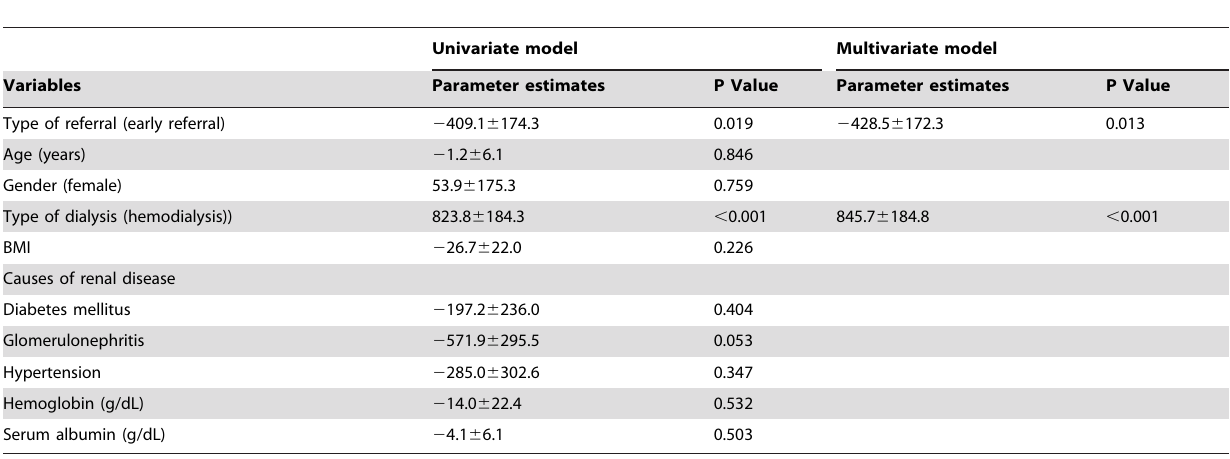
Table 3. Multivariate analysis for the medical costs during the first month after dialysis